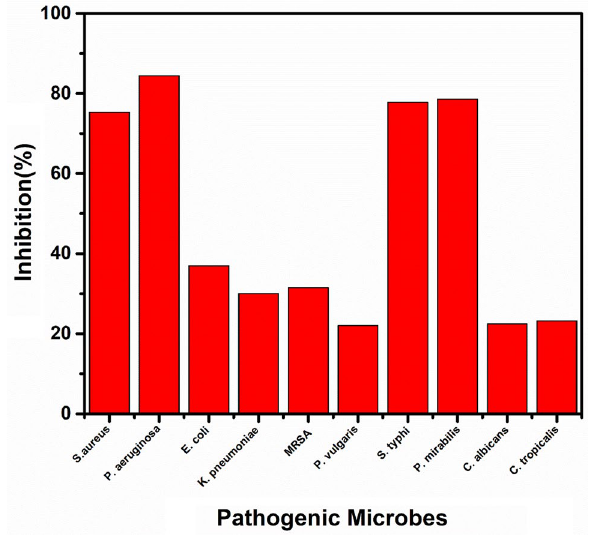
Figure 5. Antibiofilm activity of Co-doped TiO 2 against different pathogenic microbes as inhibition